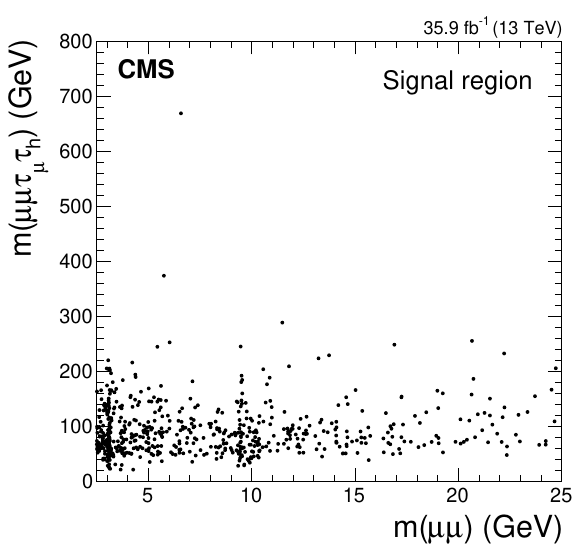
Figure 6 . Observed data distribution, as a function of the 4-body visible mass and (cid:22)(cid:22) invariant mass for the signal region; 614 events are